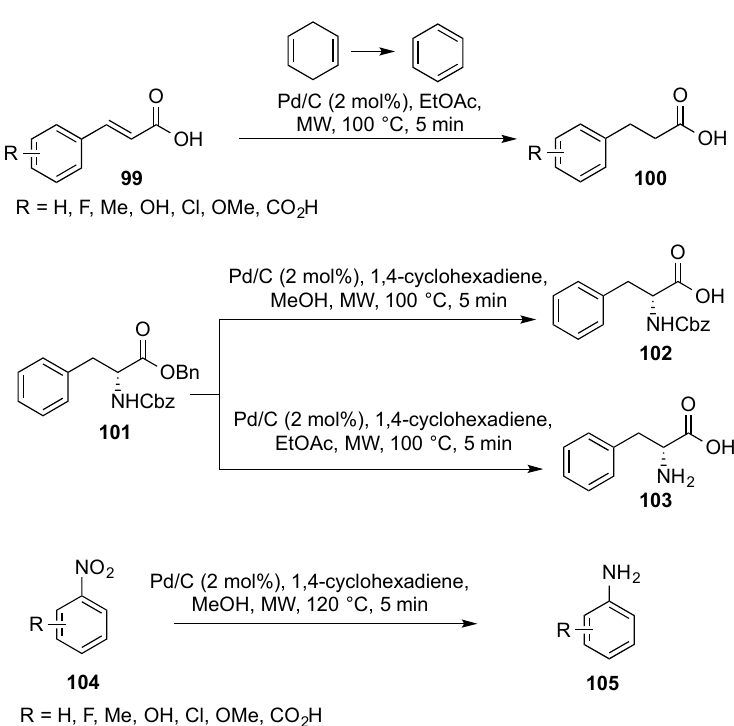
Scheme 30. Pd/C catalyzed hydrogen transfer with cyclohexenes.